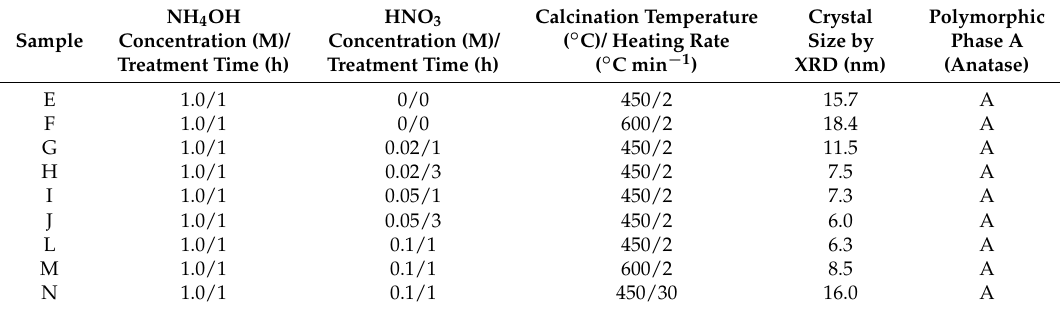
Table 3. Anatase crystal sizes of samples obtained by hydrolysis of Ti(OC 2 H 5 ) 4 in mixture with Zr(OC 3 H 7 ) 4 (5 mol%) catalysed for 1 h in the presence of 1.0 M NH 4 OH and peptized or not with different concentration of HNO 3 for 1 h or 3 h followed by heat treatment for 2 h at 450 °C or 600 °C